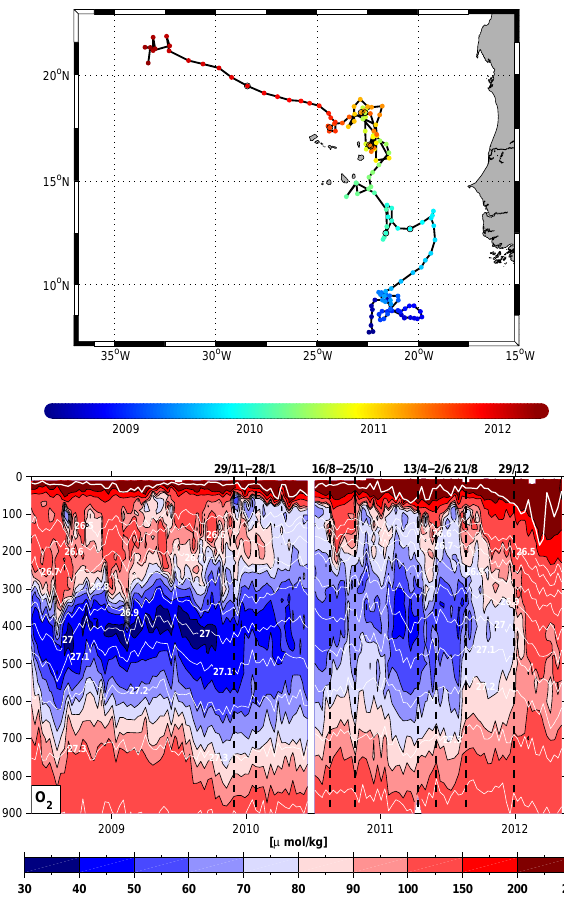
Figure 9. Measurements of float f350 in the tropical eastern North Atlantic between April 2008 and May 2012 with float path (color coded) in time (top) and oxygen distribution (bottom) in µmolkg − 1 (color) vs. time in the upper 900m; density contours are marked in white, the mixed layer depth defined for the depth where the density is 0.125kgm − 3 larger than at the surface as the thick white line. Some dates bounding anomalous oxygen distributions are marked on top of the